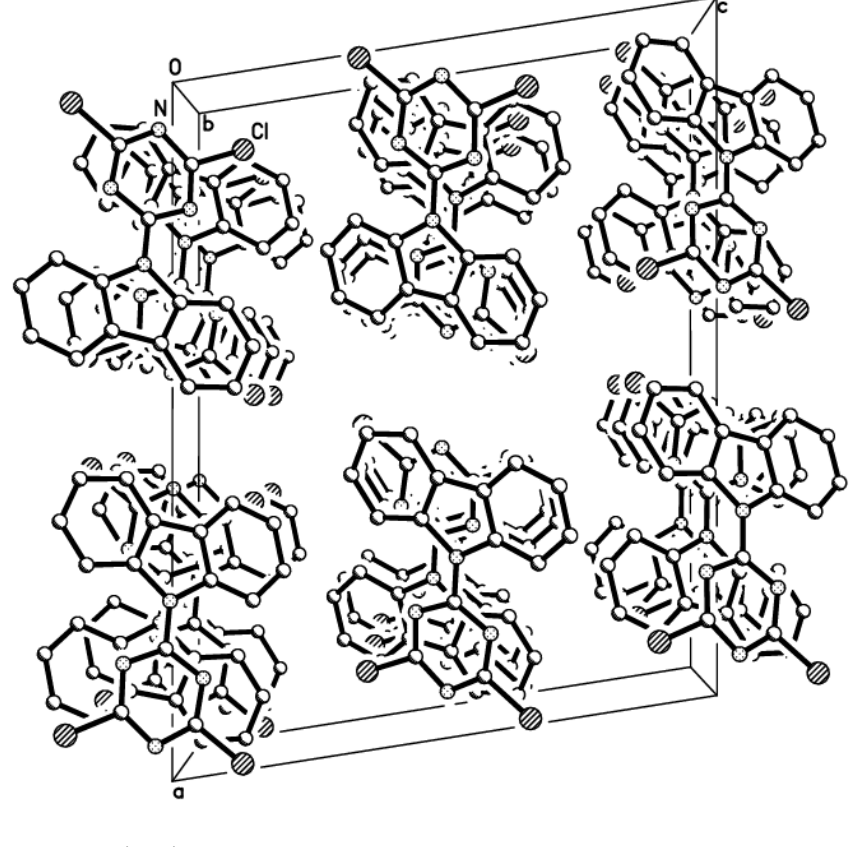
Figure 3. Crystal packing of ( 3 ) showing the p -stacking pattern of molecules along [010] . H-atoms are